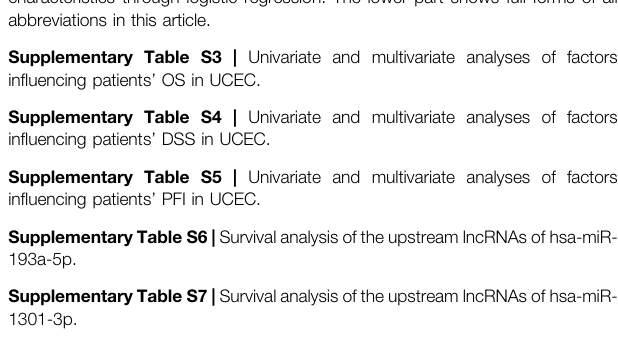
the SRR expression pro fi le at the mRNA expression and CNV level. Red bubbles represent positive correlations. The deeper the color, the higher the correlation. Bubble size positively correlates with FDR signi fi cance. The black outline border indicates FDR ≤ 0.05. (D) Survival difference between CNV groups. Bubble color and size represent the Log-rank p -value. The bubble color represents the signi fi cance of the Log-rank p -value, and the bubble size positively correlates with the signi fi cance of the Log-rank p -value. The black outline border indicates Log-rank p -value ≤ 0.05. Supplementary Figure S9 | Comparative mutation and methylation analysis of SRR. (A) ThehorizontalaxisrepresentstheUCECSRR-lowandSRR-highexpressiongroups. The vertical axis represents the gene mutation distribution, and different colors represent different mutation types. (B) The correlation between SRR expression and DNA methylation of the SRR promoter region from MEXPRESS in UCEC. The correlation coef fi cientand p -valueontherightindicatetherelationshipbetweenSRRexpressionand DNA methylation of the promoter. * p < 0.05, *** p < 0.001. (C) The Kaplan-Meier survival associated with the promoter region cg02945294. Blue represents lower methylation status, and red represents higher methylation status. Supplementary Figure S10 | Associations between SRR expression and clinical stage (A) and grade (C) across human cancers. The horizontal coordinates indicate different tumor types, and the vertical coordinates indicate the p -value after − Log10 conversion. Red color shows signi fi cant and negative correlation, while dark shows signi fi cant and positive correlation. (B) Higher SRR expression is associated with a lower stage in UCEC. (D) Higher SRR expression is associated with a lower grade in UCEC. Supplementary Figure S11 | (A) Validation of the multivariate cox regression model.Theriskscoreofeachsampleisrankedfromsmallesttolargest,withredand blue colors representing the high and low groups of risk score. Blue circle shows a living patient, while red triangle indicates death. (B) Risk score-based survival analysis of UCEC patients, with red line denoting high-risk score group and blue denoting low-risk score group. Forest plots showing the results of the multivariate Cox regression analysis of clinicopathological characteristics affecting the DSS (C) and PFI (D) of UCEC patients. Supplementary Figure S12 | Expression, correlation, and survival analysis of the upstream miRNAs of SRR. (A) Correlation analysis of the 10 miRNAs showing signi fi cantly negative correlations with SRR in UCEC by StarBase. (B) Seven out of the10miRNAsaresigni fi cantlyhighlyexpressedinUCECcomparedwithnormaltissues through StarBase. (C) Validation of the expression differences of the 10 miRNAs by analyzingdataobtainedfromTCGA.* p < 0.05,** p < 0.01,*** p < 0.001. (D) OSanalysisof the seven overexpressed miRNAs in UCEC patients by StarBase. OS, DSS, and PFI analysis of hsa-miR-1301-3p (E) and hsa-miR-193a-5p (F) through TCGA. SupplementaryFigureS13| Expressionanalysisoftheupstream lncRNAsofhsa- miR-193a-5p. Expression analysis of the consistently predicted 13 signi fi cantly downregulated upstream lncRNAs of hsa-miR-193a-5p by StarBase (A) , GEPIA2 (B) , and TCGA (C) . * p < 0.05, ** p < 0.01, *** p < 0.001. SupplementaryFigureS14| Expressionanalysisoftheupstream lncRNAsofhsa- miR-1301-3p. Expression analysis of the consistently predicted 19 signi fi cantly downregulated upstream lncRNAs of hsa-miR-1301-3p by StarBase (A) , GEPIA2 (B) , and TCGA (C) . * p < 0.05, ** p < 0.01, *** p < 0.001. (D) OS analysis of TSPOAP1-AS1 in StarBase. (E) OS, DSS, PFI analysis of TSPOAP1-AS1 through TCGA. Supplementary Table S1 | Correlation analysis between SRR expression and clinicopathological variables in EC based on TCGA database. Supplementary Table S2 | SRR expression correlates with clinicopathological characteristics through logistic regression. The lower part shows full forms of all abbreviations in this article. Supplementary Table S7 | Survival analysis of the upstream lncRNAs of hsa-miR-